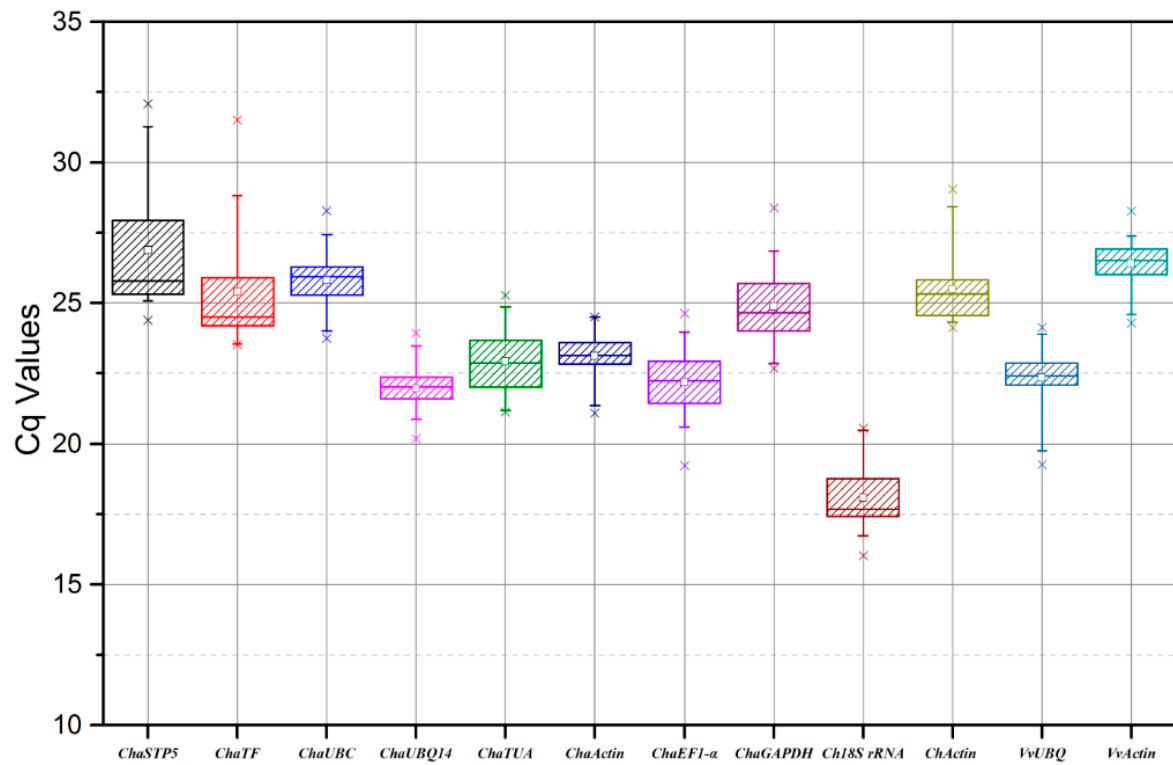
Figure 3. Cq values of candidate reference genes in 24 samples. Boxes indicate the interquartile range. Lines across the boxes depict the medians. Small white boxes within colored boxes indicate mean values. Whiskers represent the 95th and 5th percentiles. The × symbols denote minimum and maximum values.